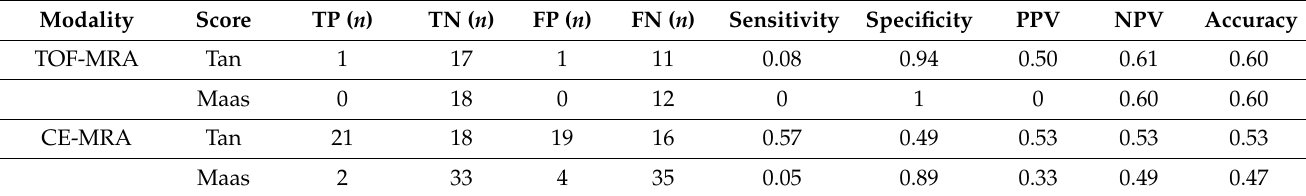
Table 3. Sensitivity, specificity, PPV, NPV and accuracy of TOF-MRA and